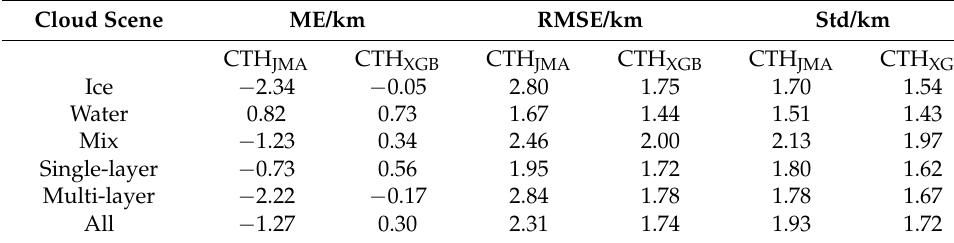
Table 3. Statistics of differences between CTH JMA and CTH XGB